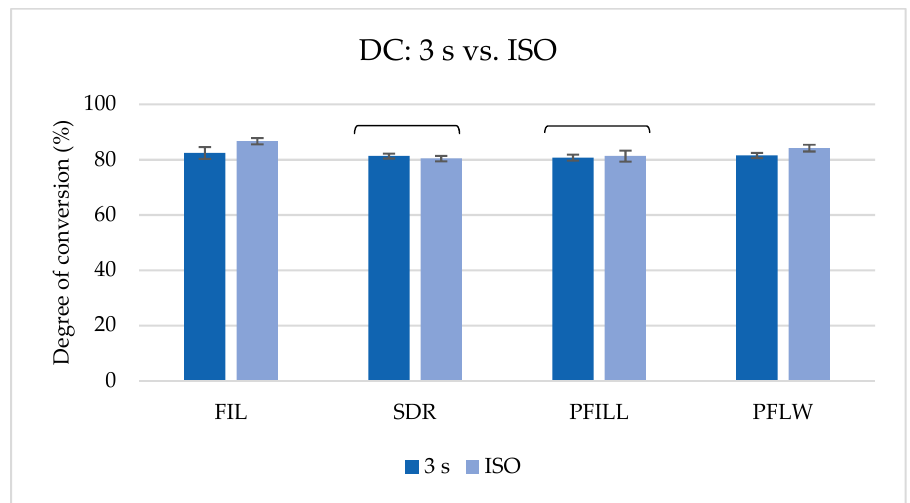
Figure 7. Comparison of degree of conversion (%) between ISO at 2 mm and 3 s group at a 2 mm depth of the top specimen (mean values ± 1 standard deviation). Brackets denote statistically similar pairs of 3 s and ISO groups of the same material ( p < 0.05).